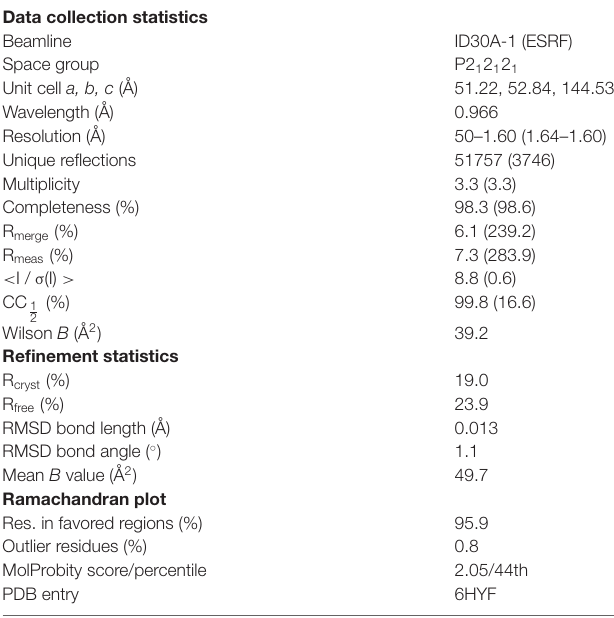
TABLE 3 | Crystallographic data collection and refinement